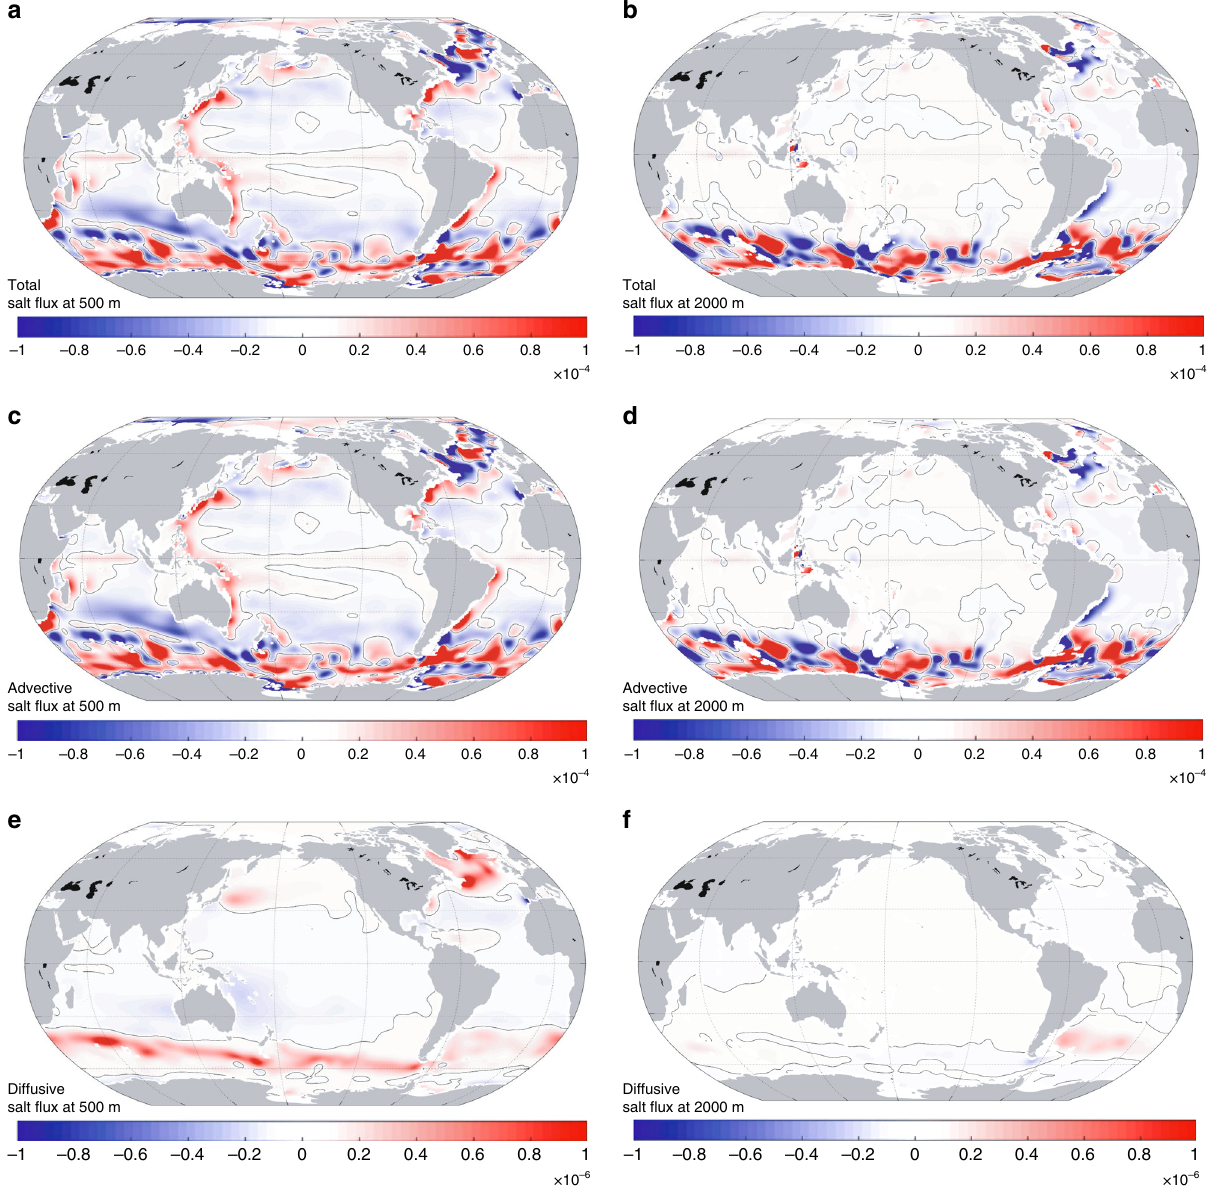
Fig. 5 Spatial distribution of the ocean vertical salt fl uxes. a , c , e , 22-year means of the net ( a ), advective ( c ), and diffusive ( e ) vertical salt fl uxes at 500 m. b , d , f , 22-year means of the net ( b ), advective ( d ), and diffusive ( f ) vertical salt fl uxes at 2000m. In all panels, positive values stand for upward salt transport psu m s − 1 . Note the scale varies in different